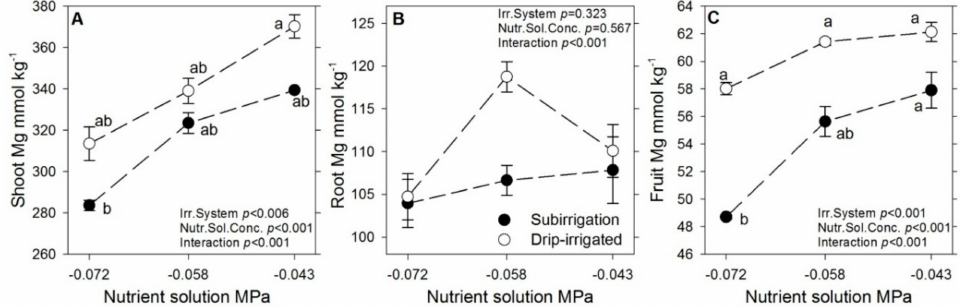
Figure 8. ( A – C ) E ff ect of the irrigation system and the concentration of the nutrient solution on magnesium concentration in tomato ( Solanum lycopersicum L.) plants. ANOVA significance for both factors, irrigation system (Irr. System) and nutrient solution concentration (Nutr. Sol. Conc.), and the interaction is shown. Means with the same lower-case letter indicate non-significant di ff erences according to Tukey’s multiple comparison test. Bars represent the standard error of the mean ( n =